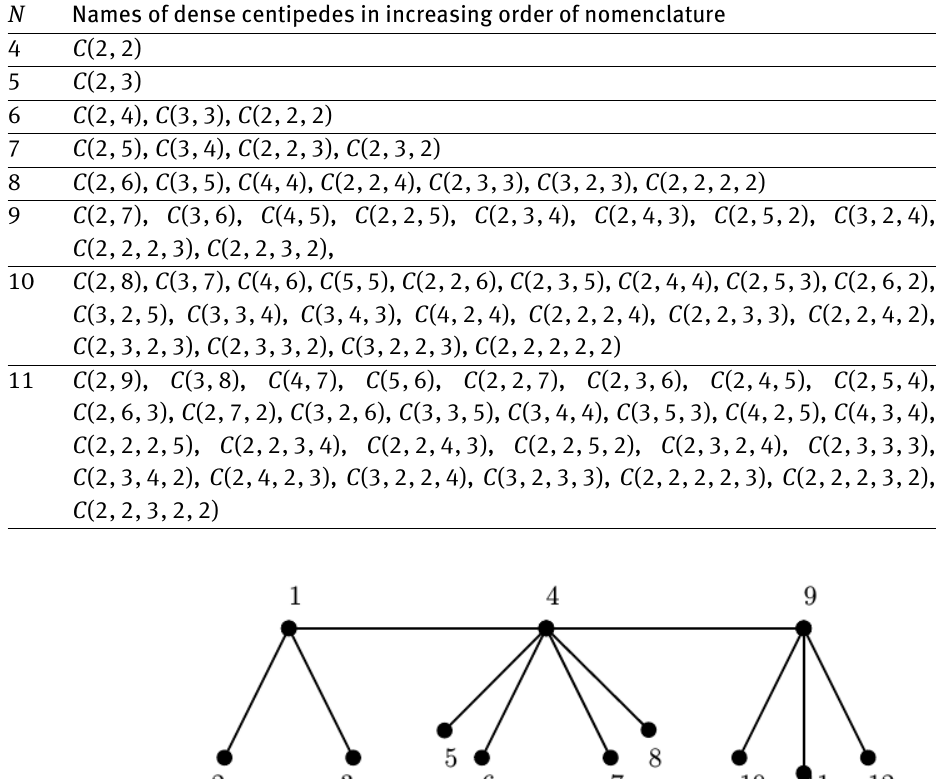
Table 1: List of some dense centipedes